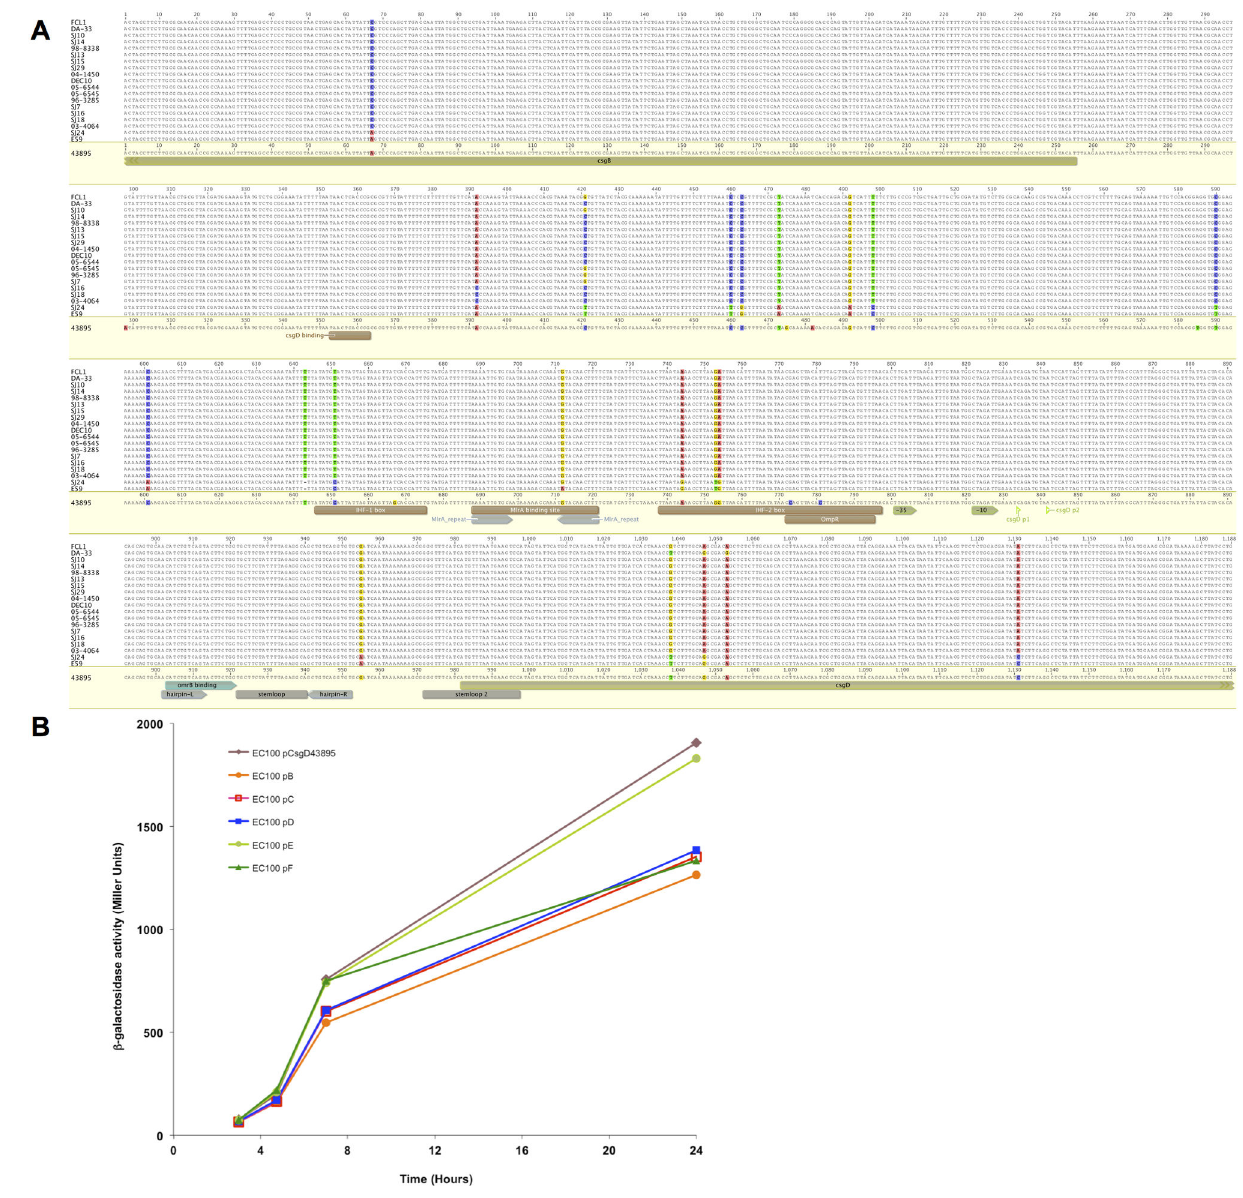
Figure 5. CsgD promoter sequence and activity. (A) Alignment of csgD promoters and (B) β-galactosidase activities (Miller Units) over time. A representative time course was